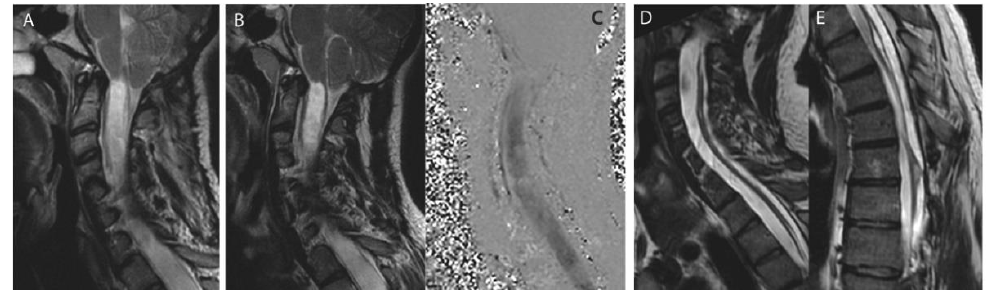
Figure 3. Shunting revision after Chiari decompression failure. Case of a 20 years-olf male patient with a Chiari I malformation with syringomyelia and associated scoliosis before index decompres- sion surgery ( A ). Extensive foraminal arachnoiditis was observed during surgery, confirming the discrepancy between moderate tonsillar herniation and holocord syringomyelia. Persistant ( B ) and circulating ( C ) syrinx with no CSF flow at the craniovertebral junction ( C ). CSF diversion was per- formed: resolution of the syringomyelia ( D ) after placement of a syringo-peritoneal catheter at the lower extremity of the syrinx ( E ).